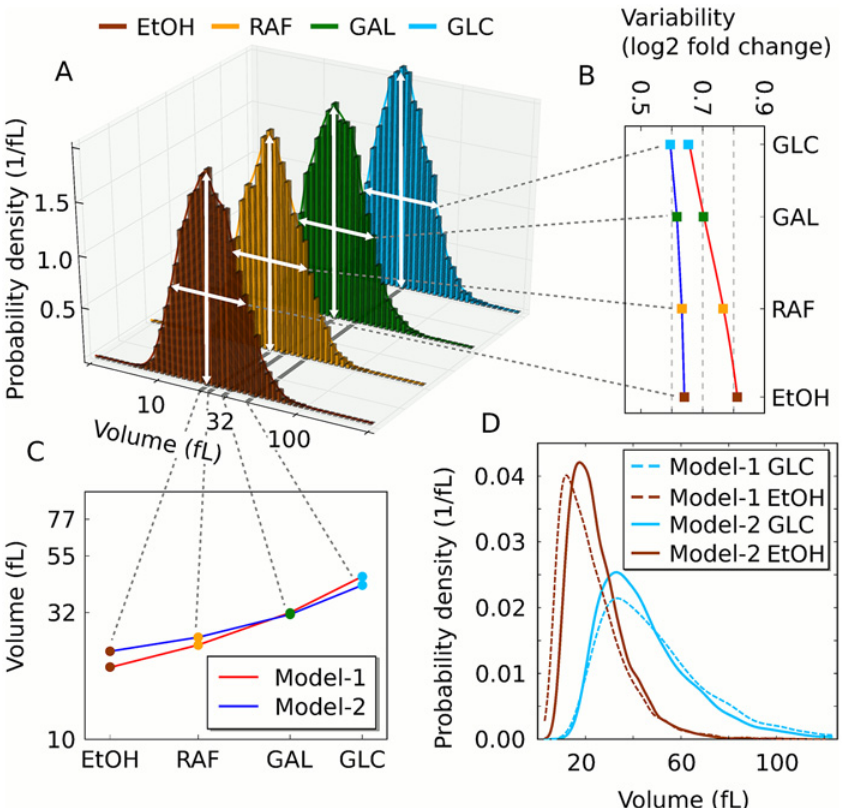
Fig 5. Cell size statistics. (A) Cell size distributions are shown for in silico cultures simulated with Model-2 in glucose (GLC — light blue), galactose (GAL — green), raffinose (RAF — yellow) and ethanol (EtOH — brown). (B-C) Relative variability in cell size (B) and average cell size (C) is shown for in silico cultures obtained from simulations with Model-1 (red) and Model-2 (blue) in same conditions as in (A). (D) Cell size distributions density estimates of Model-1 (dashed lines) and Model-2 (solid lines) on a linear scale. Cell size is log- normally distributed [32], hence size average in (B) and relative variability in (C) are computed on